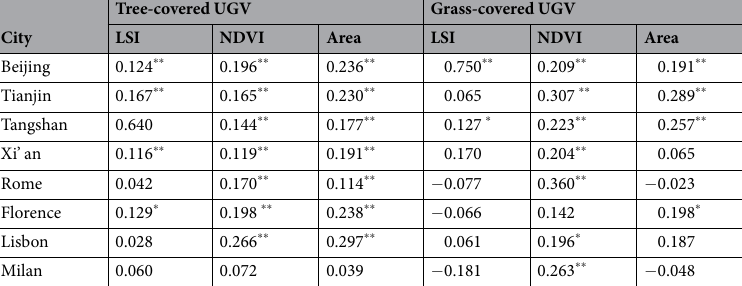
Table 2. The relationship between three indexes (LSI, NDVI, area) and the cooling extent of UGV. * Correlation is significant at the 0.05 level (2-tailed). ** Correlation is significant at the 0.01 level